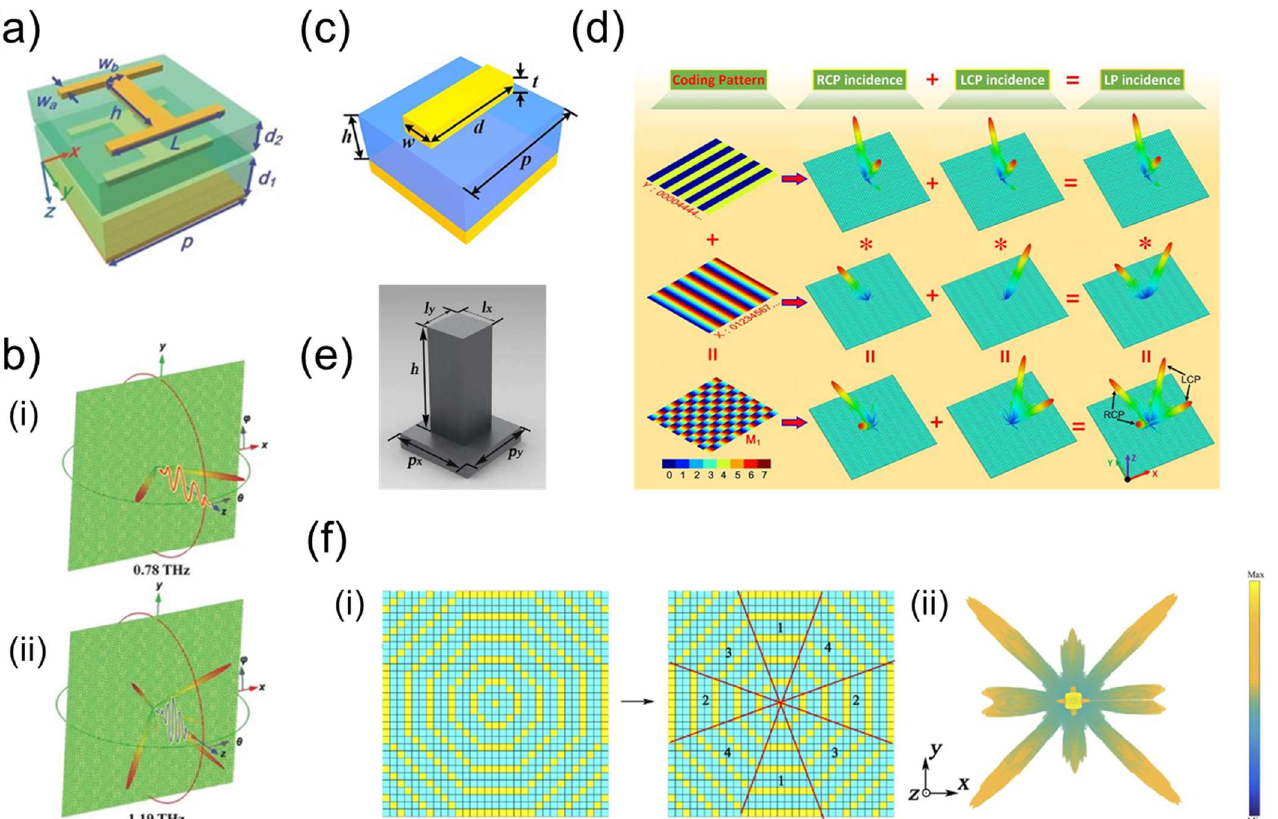
Figure 14. ( a ) Coding cell structure consisting of two ELC structures and a metal ground patch separated by two polyimide layers [128]. Copyright 2016 John Wiley and Sons ( b ) The coding sequence S2 of 72 × 72 coded particles, 2D scattering simulation pattern at 0.78 THz ( i ) and 1.19 THz ( ii ) [128]. Copyright 2016 John Wiley and Sons. ( c ) Schematic diagram of the PB-encoded metasurface unit. Reprinted with permission from [130]. Copyright 2017 American Chemical Society. ( d ) Controlling multiple scattered beams and polarizations through convolution operations. “∗” stands for convolution. Reprinted with permission from [130]. Copyright 2017 American Chemical Society. ( e ) Schematic diagram of the rectangular silicon coding element [131]. ( f ) ( i ) The “offset” encoding sequence with eight split beams. ( ii ) The simulation results of the 3D far-field scattering pattern [131]. Li et al. designed a reflective terahertz coding beam splitter [132]. The coding unit